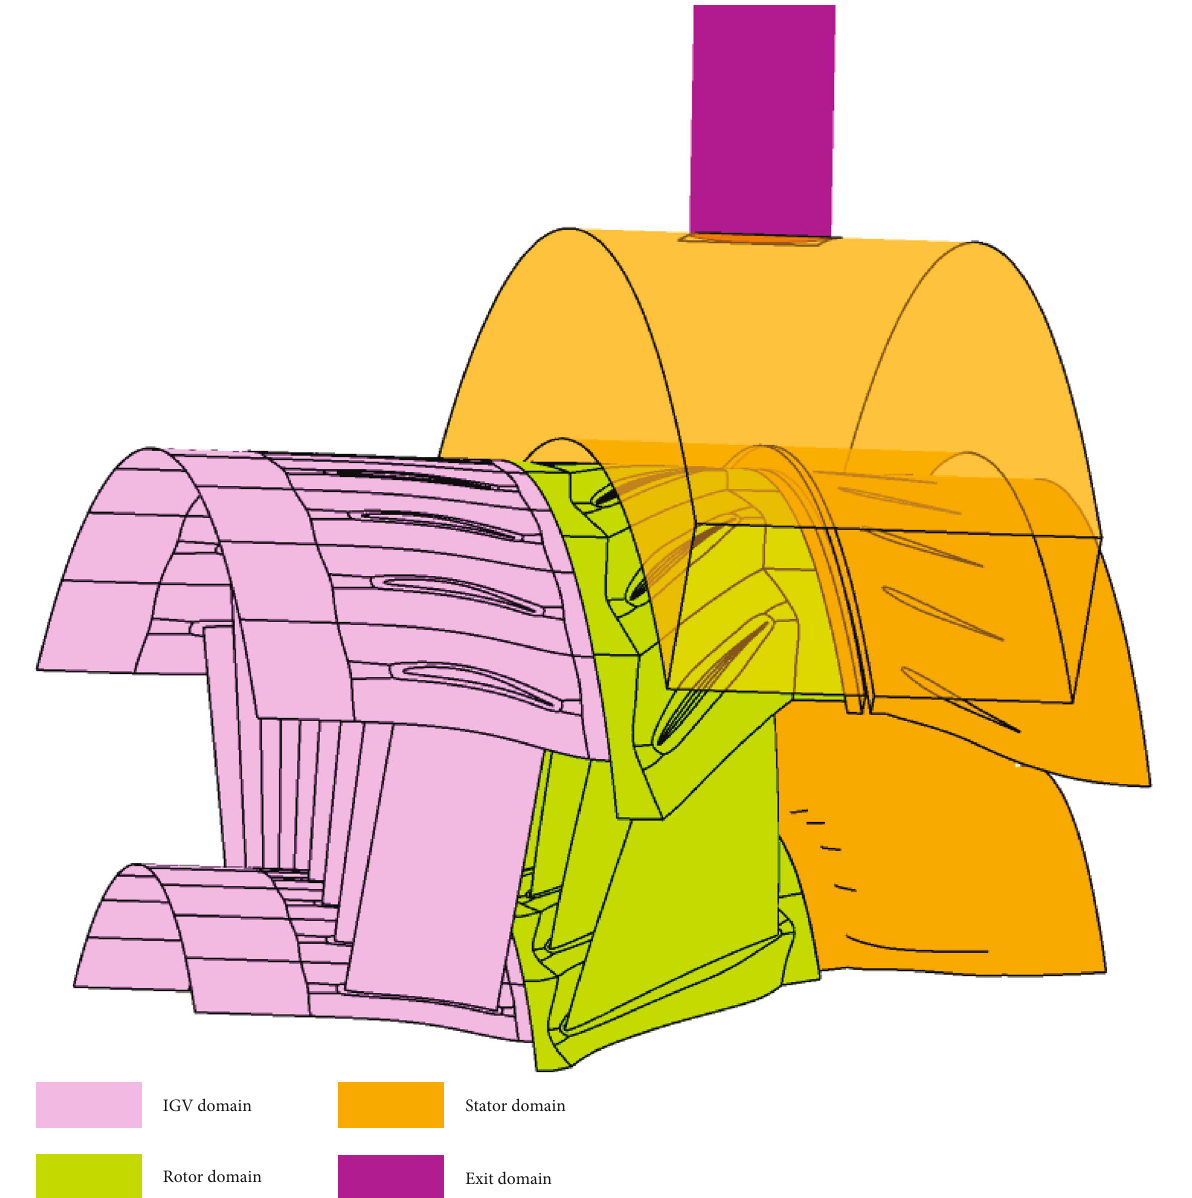
Figure 3: Computational